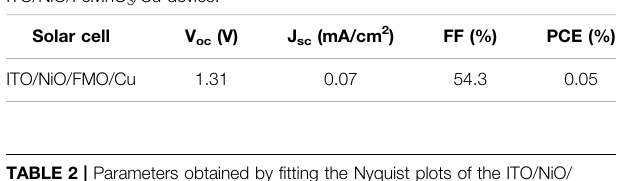
TABLE 2 | Parameters obtained by fi tting the Nyquist plots of the ITO/NiO/ FeMnO 3 /Cu